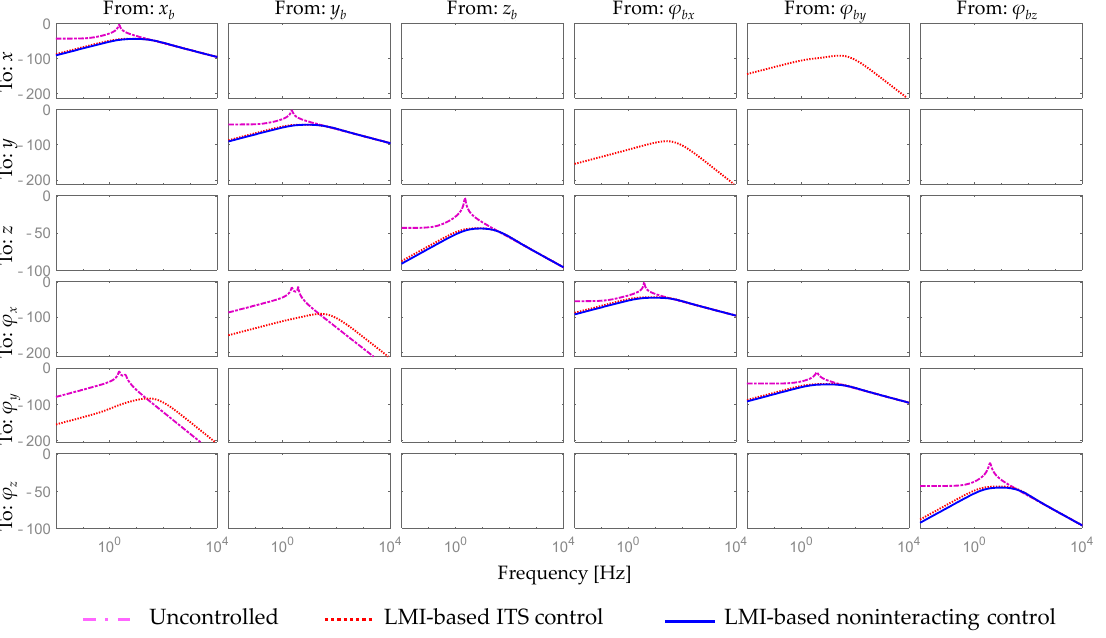
tions appearing along with the translational movements. Aside from using the ITS control